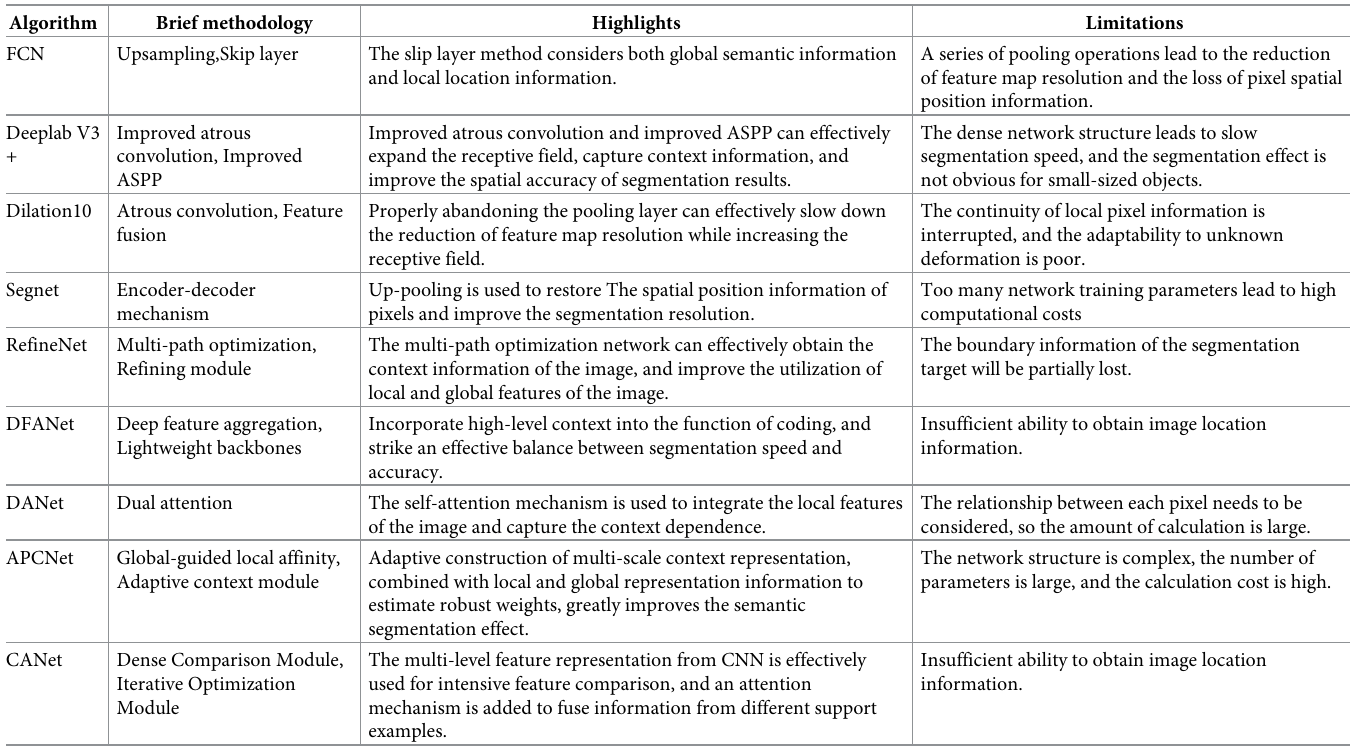
Table 1. Comparison of semantic image segmentation